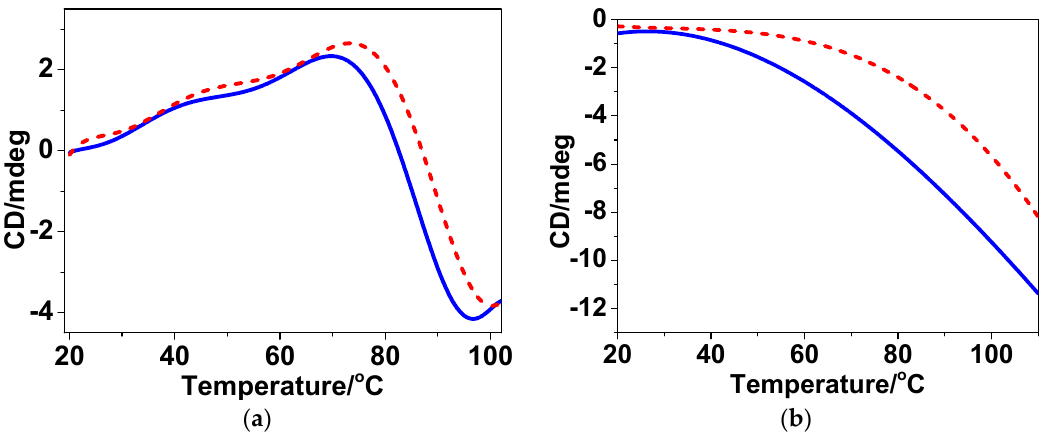
Figure 6. Typical CD melting curves of ( a ) CT-DNA; and ( b ) bcl-2 G-quadruplex DNA without (—) or with (- - -) 1b in the incubation buffer. The CD signal was recorded with a positive band at 280 nm. [DNA] = 100 μ M; [Ru] = 10 μ M.